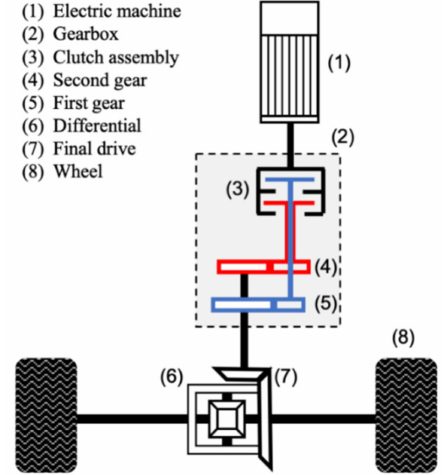
Figure 1. Two-speed dual clutch gearbox